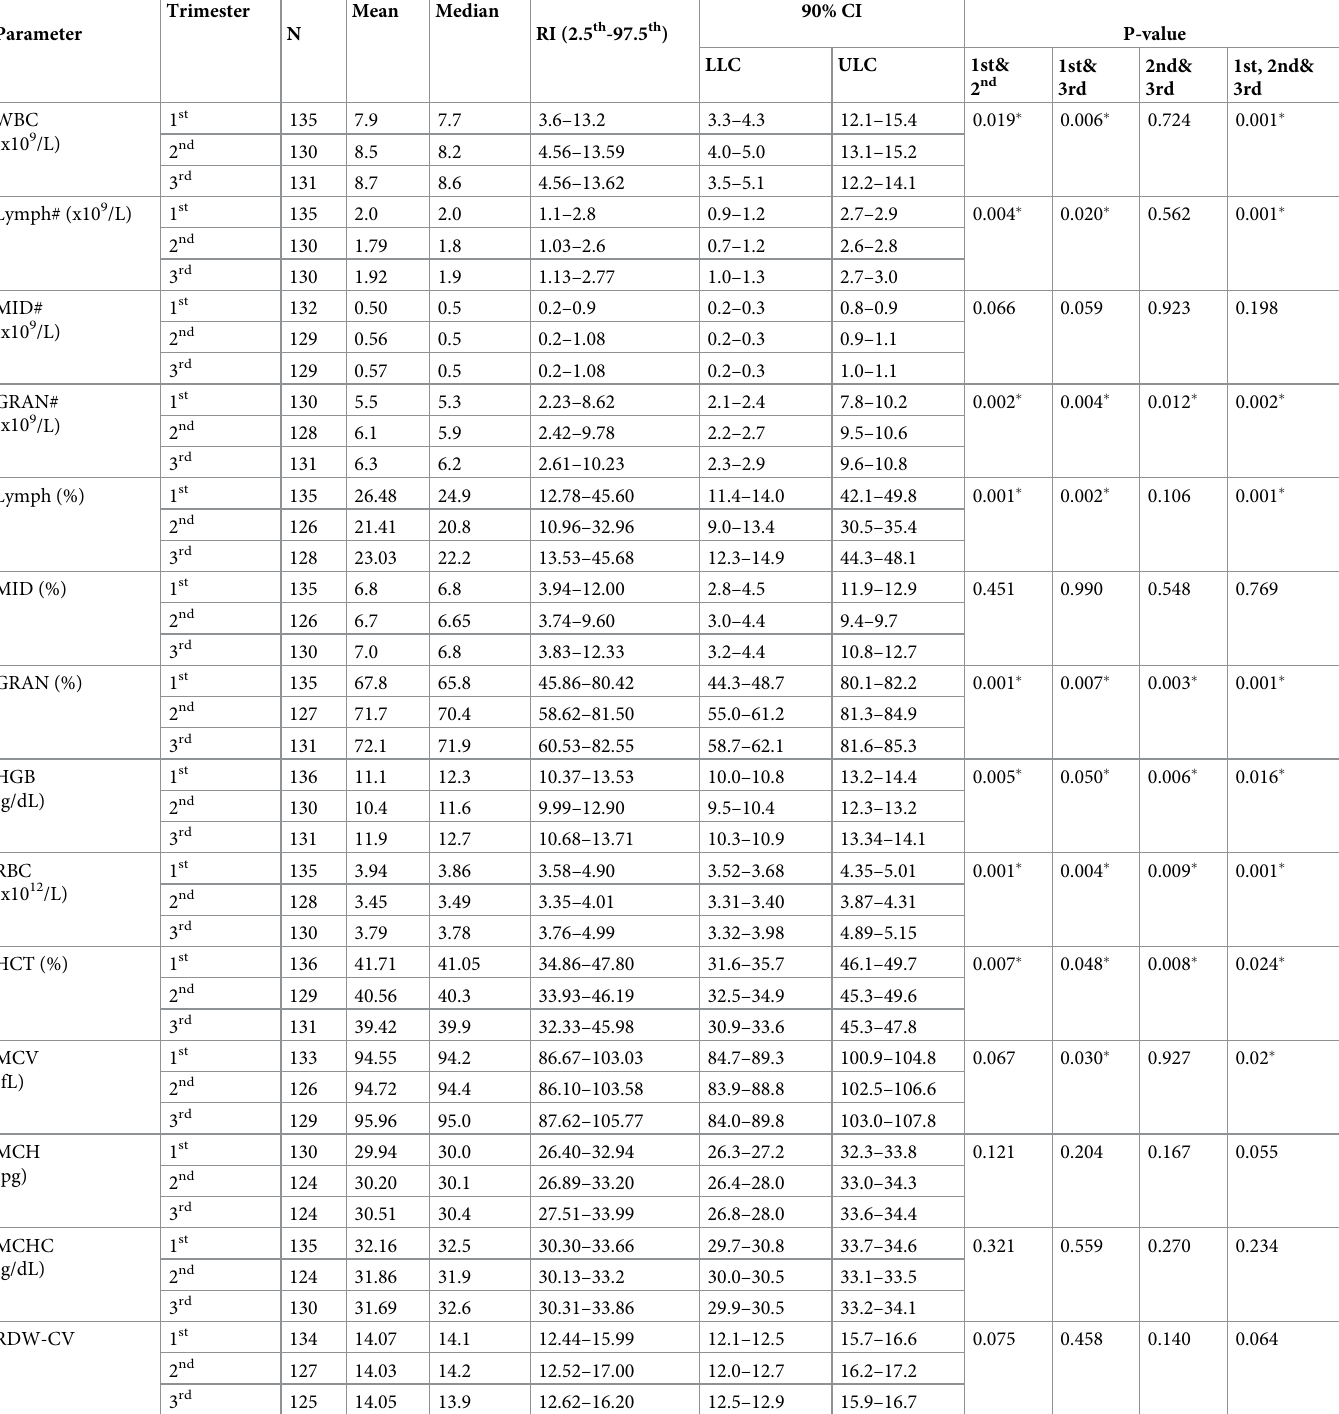
Table 3. Mean, median, 95%(2.5th-97.5th) RIs with 90% CI for lower and upper reference limit of hematological parameters stratified by gestational period (tri- mester) of South Wollo zone, Amhara Region, Northeast Ethiopia, from June to August, 2019.